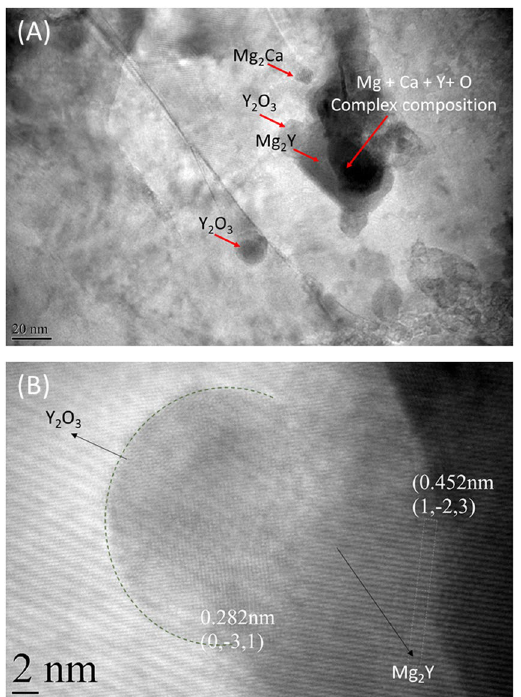
Figure 2. High-resolution transmission electron micrographs of the nanocomposite. ( A ) Distribution of phases and reinforcement in the matrix of the Mg-1.8Y/1CaO nanocomposite; and ( B ) a matrix-reinforcement interface showing the yttria nanoparticle emerging out of Mg 2 Y